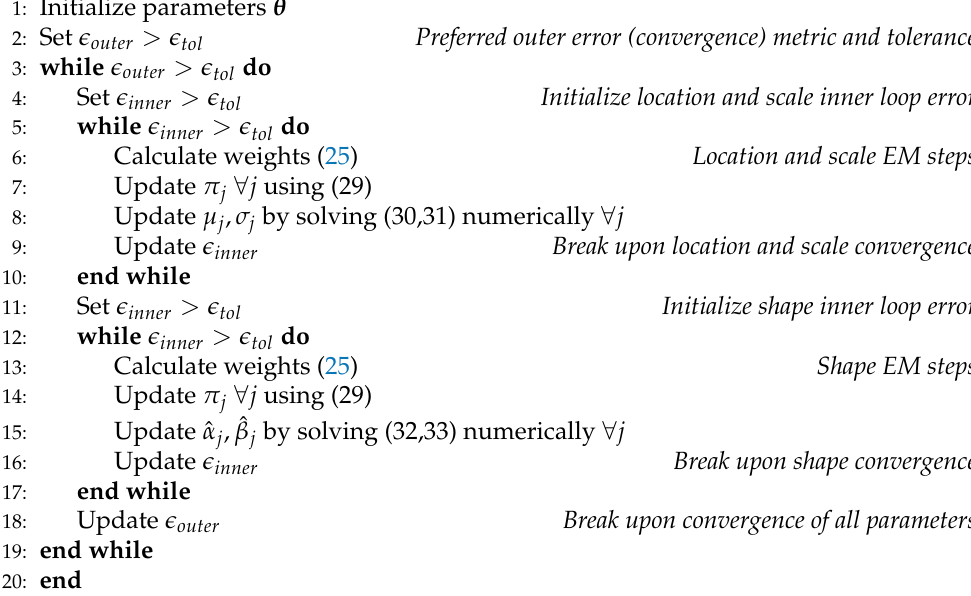
Algorithm A1 Modified EM algorithm for k component